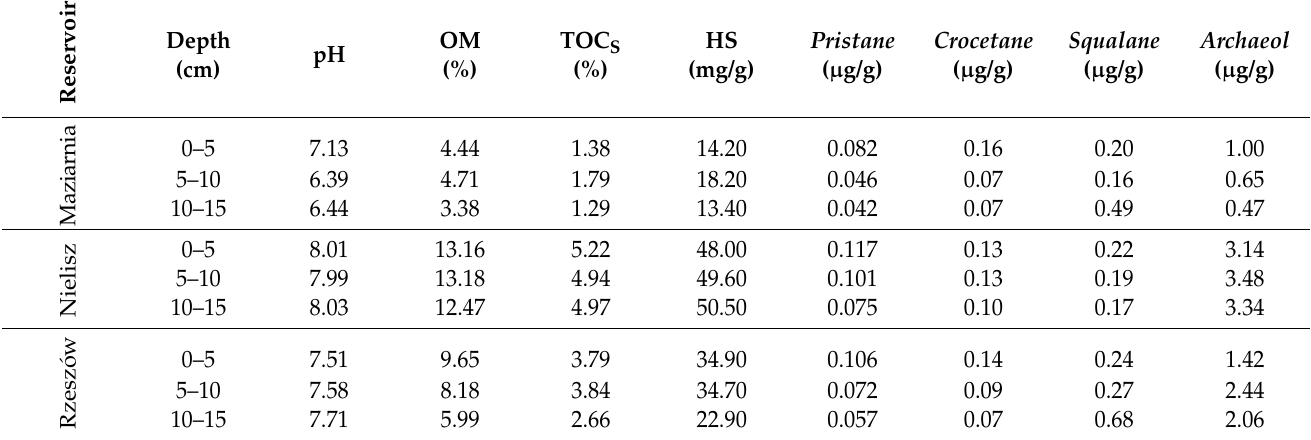
Table 2. Selected parameters characterising sediments in the reservoirs